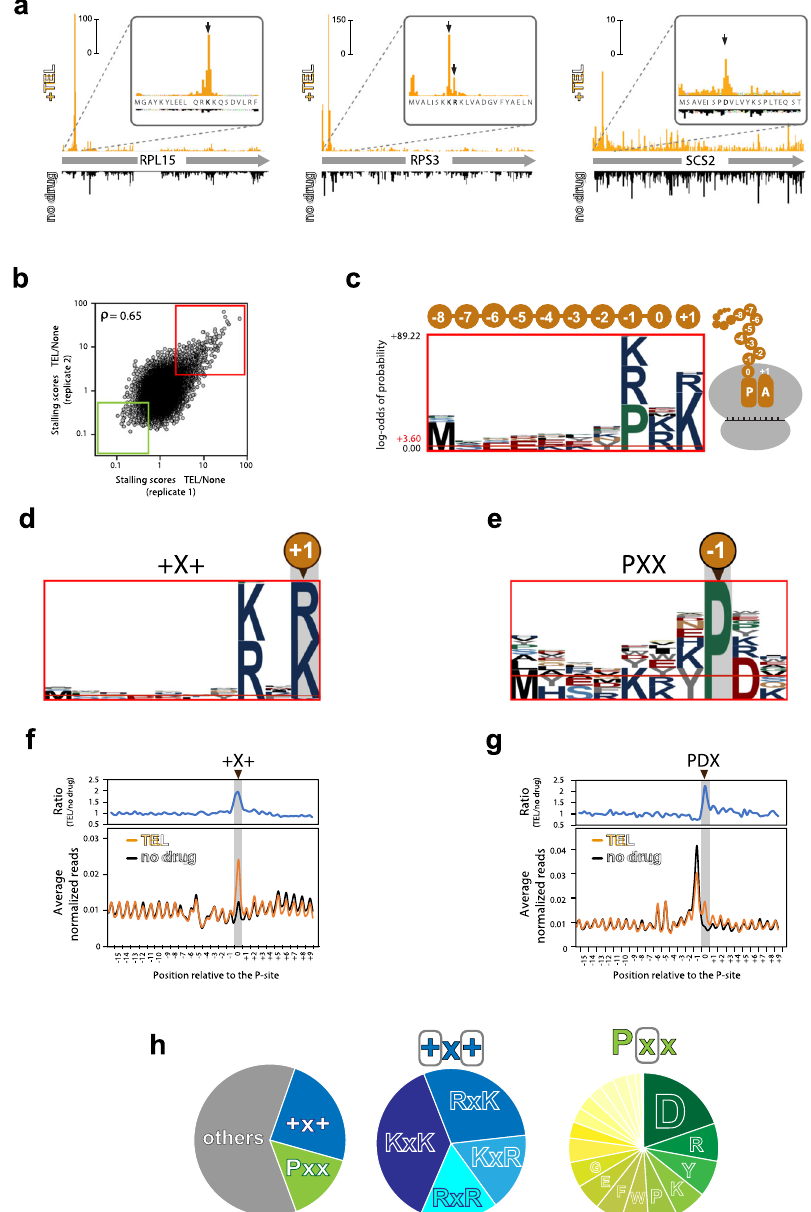
Fig. 4 Macrolides arrest translating ribosomes at speci fi c sequences. a Examples of TEL-induced translation arrest within S. cerevisiae genes. Comparison of ribosome footprint densities in untreated G2400A yeast cells ( “ no drug ” , downwards extending black plots) or cells treated for 10 min with 1.5 mg/mL (8× MIC) of TEL (upwards-extending orange plots). The arrows indicate prominent footprint density peaks; the amino acid in the P site of the stalled ribosome is shown in bold. b The correlation of pause score ratios in TEL-treated and untreated cells for 46,445 sites within the actively expressed genes between two independent experiments. The red rectangle includes the 749 sites with ≥ 2.5-fold enrichment of ribosomal density in TEL samples in both experiments, which were used for the pLogo analysis shown in c – e . The green rectangle marks the 1809 sites of the least ef fi cient TEL action (pause scores reduced by ≥ 2-fold in the TEL-treated samples). c pLogo analysis of the sequences of the nine C-terminal residues of the nascent protein (positions 0 to − 8) and the A-site amino acid (position + 1) at the sites of strongest TEL action. d pLogo analysis of the sites of the strongest TEL action conforming to the + X + arrest motif. e pLogo analysis of the strongest arrest sites where proline (P) is present in the penultimate position of the nascent chain. f , g Bottom panels: Metagene analyses of ribosome density around the + X + ( f ) and PDX ( g ) arrest motifs in TEL-treated (orange plots) and untreated (black plots) cells. Top panels show the ratio between the TEL and control metagene plots. The P-site codons of the + X + and PDX motifs (highlighted by gray shadowing) are assigned as position 0. Note that the large metagene peak upstream from the highlighted peak in the PDX plot results from TEL- independent ribosome stalling at Pro codons 54 . h Relative occurrence of the different prevalent motifs among the 749 sites of strongest TEL-induced arrest. Left pie-chart shows all 749 sites, middle chart represents the subset of sites conforming to the + X + motif and the chart on the right illustrates the subset of sites corresponding to the PXX